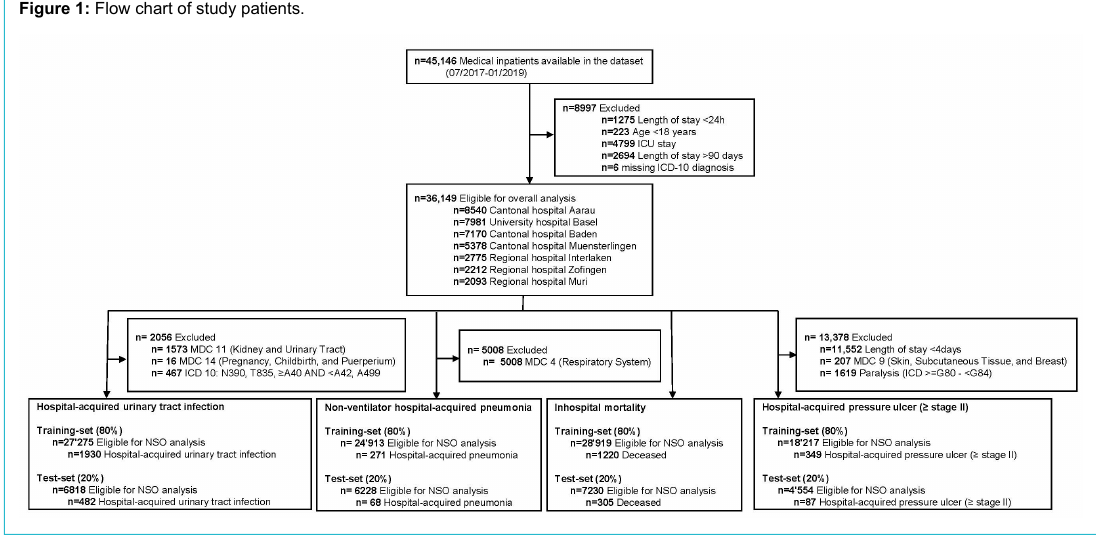
Figure 1: Flow chart of study patients.